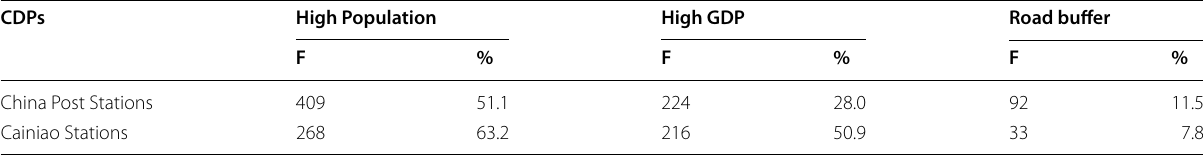
Table 2 Quantitative results of CDPs within the cluster areas of high population, high GDP, and main corridor buffer CDPs High Population High